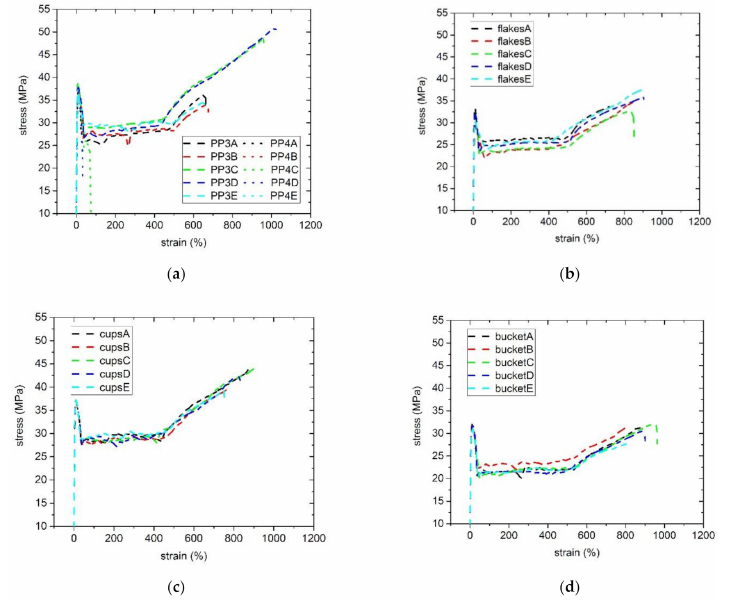
Figure 8. Stress-strain curves of all samples (PP3 and PP4 ( a ), flakes ( b ), cups ( c ), bucket ( d )) obtained from tensile